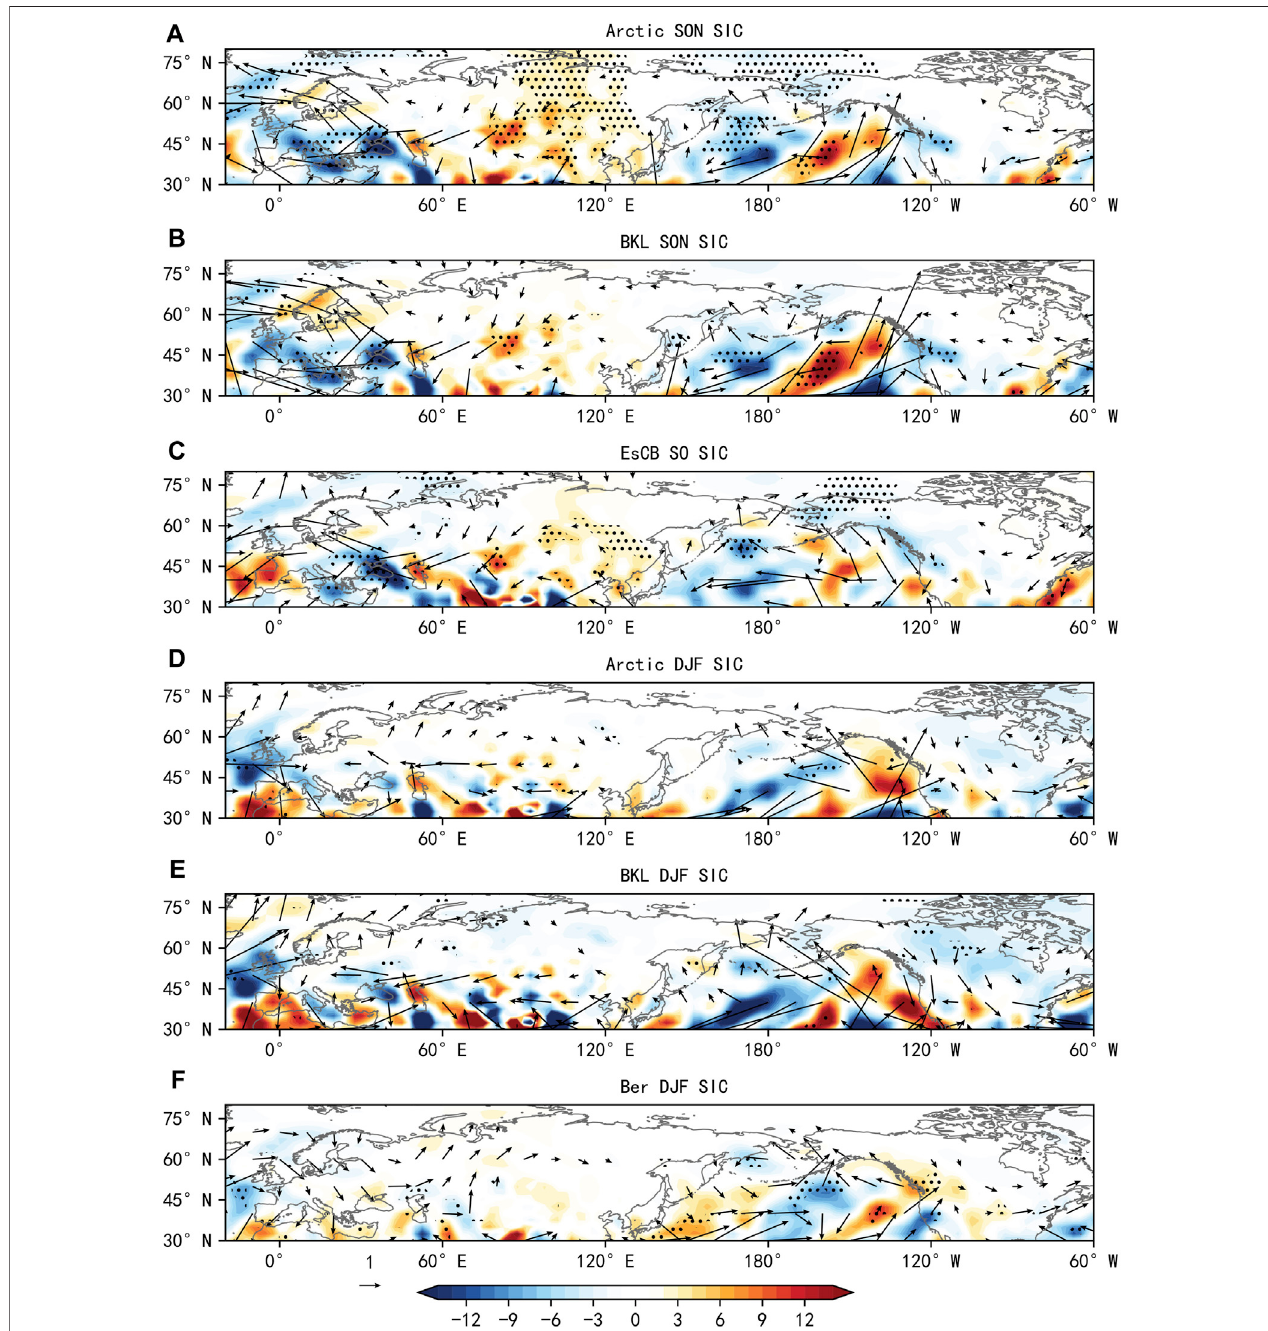
FIGURE 9 | As in Figure 7 but for the interdecadal component of moisture transport fl uxes and associated divergence.